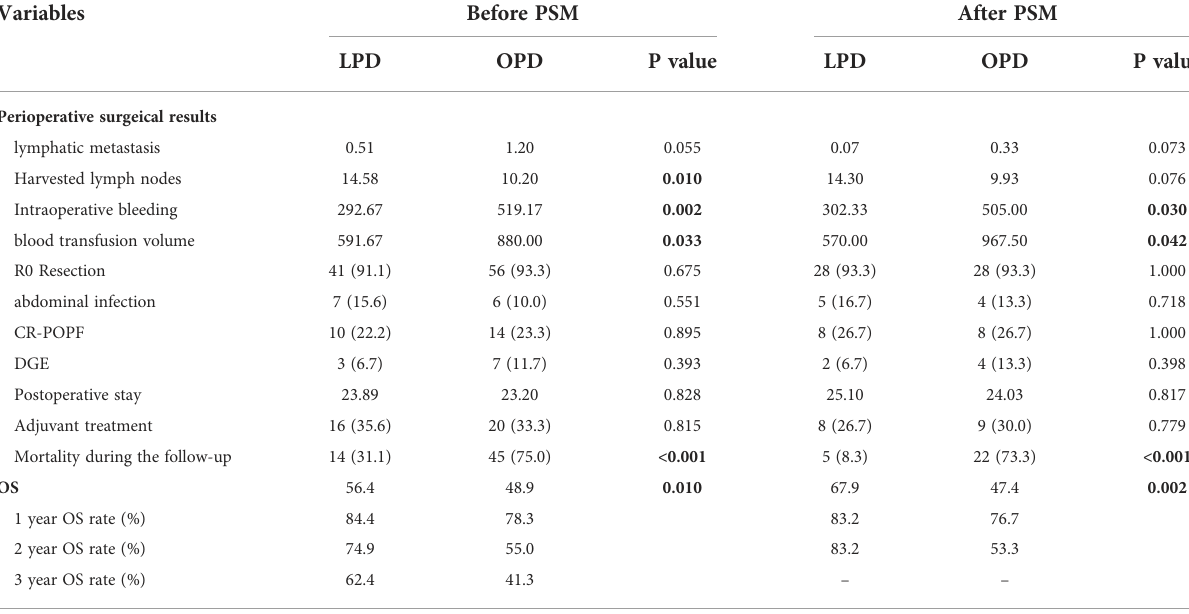
TABLE 2 Comparisons of clinical outcomes between patients with LPD and OPD before and after propensity score